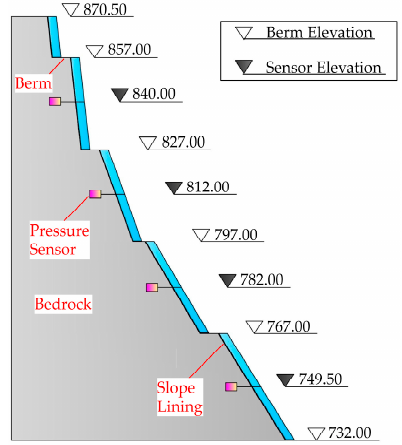
Figure 4. Elevations of berms and sensors on different slope layers.